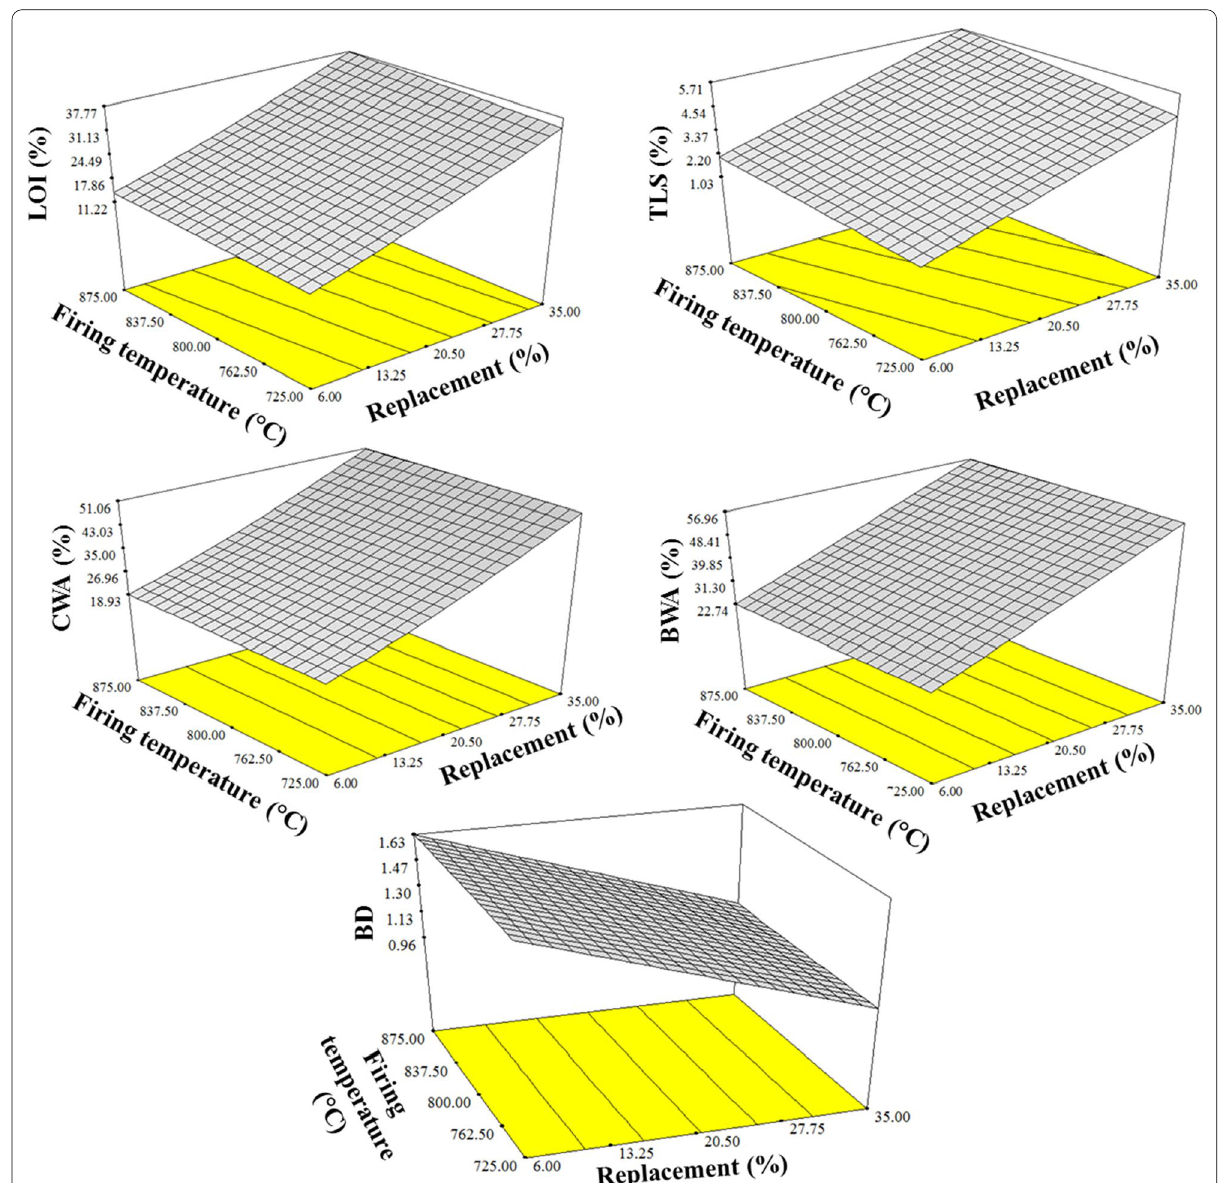
Fig. 10 Three‑dimensional graphs for clay‑PB fired bricks; models of: LOI, TLS, CWA, BWA, and